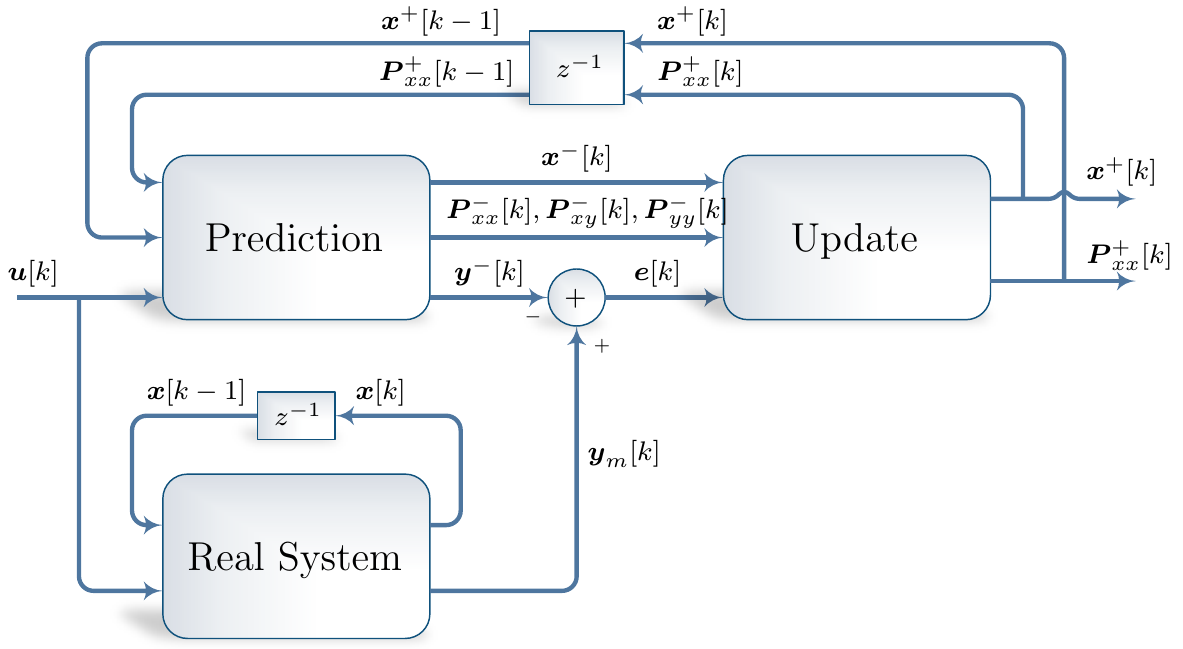
Figure 2. Block diagram of a stochastic state